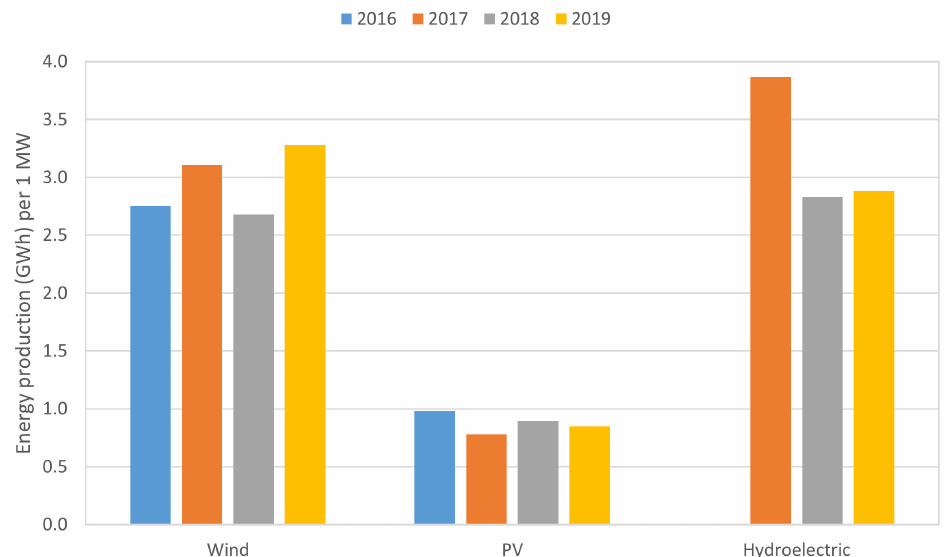
Figure 9. Annual energy production per 1 MW of installed power.